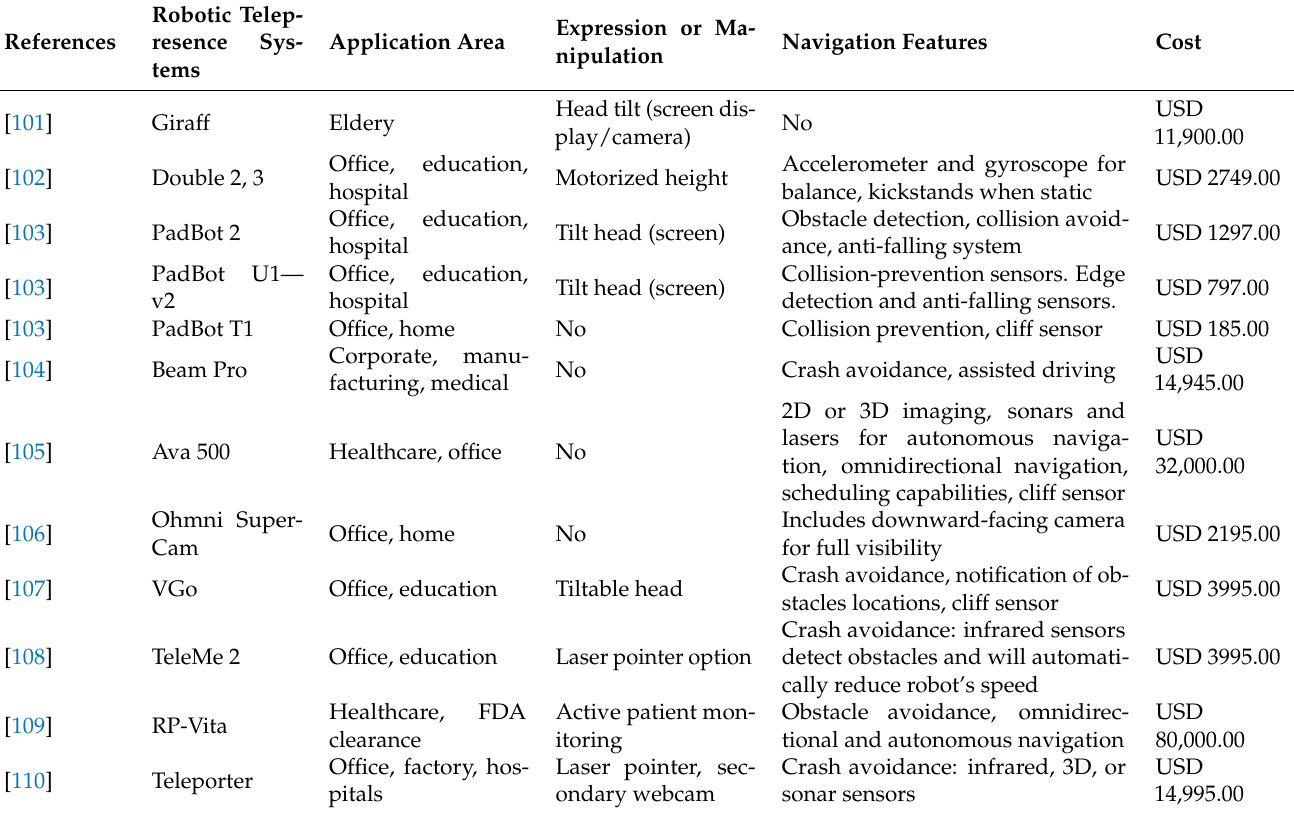
Table 4. Mobile robotic telepresence (MRP) systems: full market